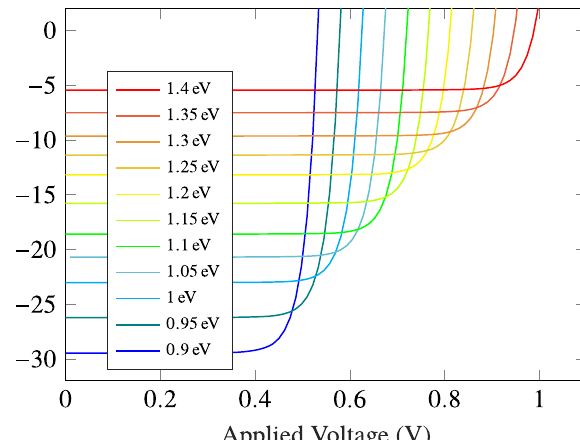
Fig. 6. Simulated J – V characteristics for 350 nm thick fi ltered bottom cells of different bandgaps. The top cell bandgap and thickness are fi xed at 1.55 eV and 350 nm, respectively. Increasing the bottom cell bandgap result in increases current and reduced output voltage.